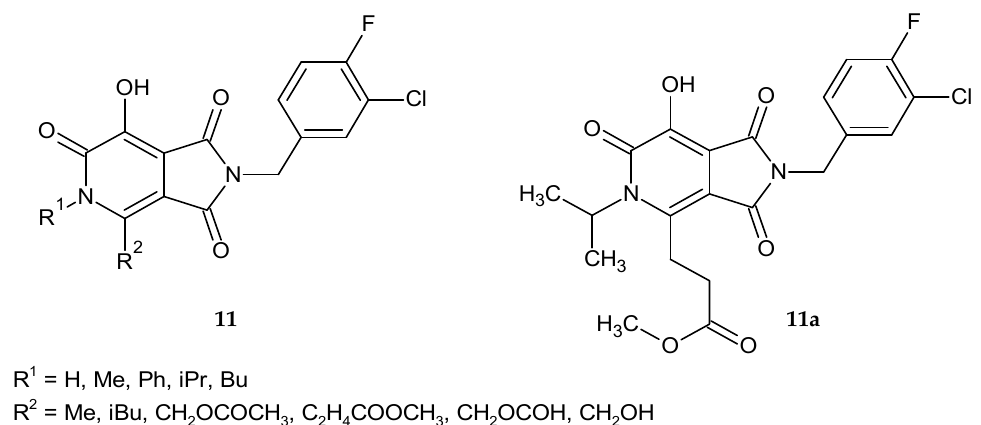
Figure 7. 2 ‐ (3 ‐ Chloro ‐ 4 ‐ fluorobenzyl) ‐ 7 ‐ hydroxy ‐ 1 H ‐ pyrrolo[3,4 ‐ c ]pyridine ‐ 1,3,6( 2H,5H ) ‐ trione derivatives 11 and the most potent compound 11a .